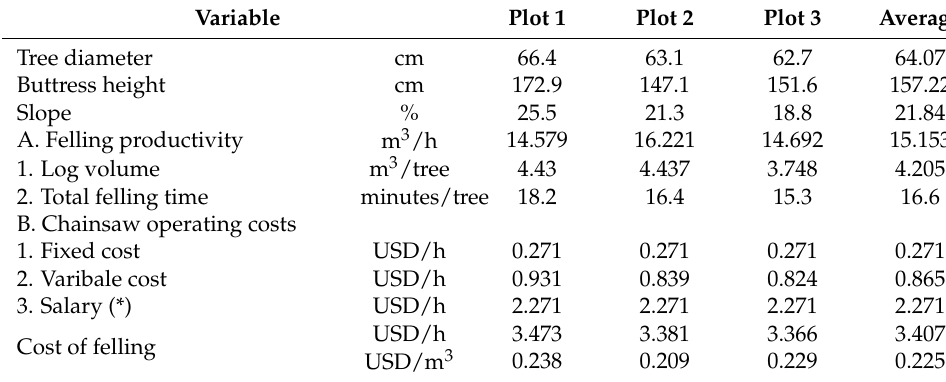
Table 2. Productivity and felling costs in West Papua,